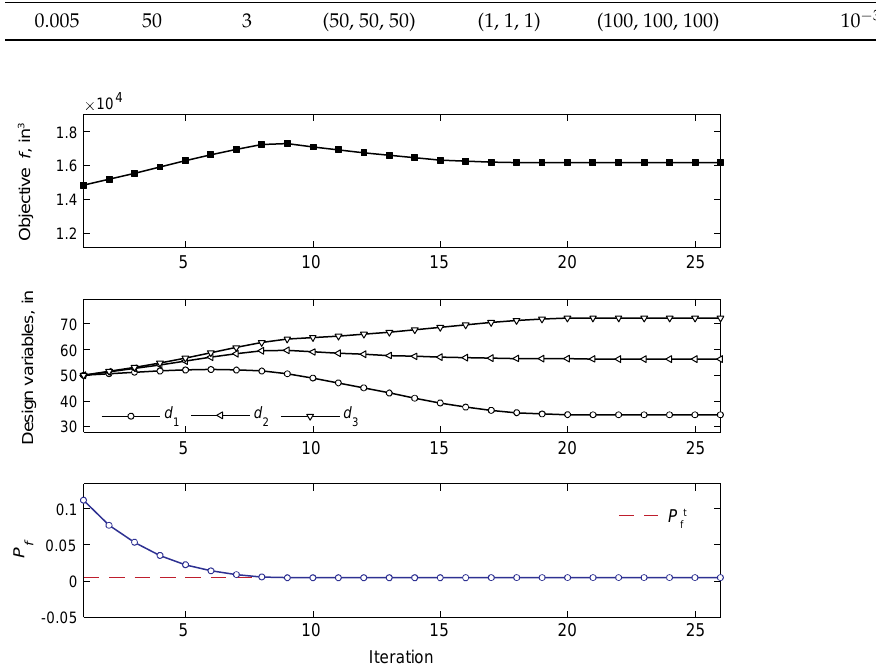
Figure 8. Convergence history of the objective function, design variables, and probabilistic constraints (by RBDO/CS–SORM-i). Table 8. Results obtained using the RBDO/CS–SORM/SORM-i for the cantilever beam. RBDO